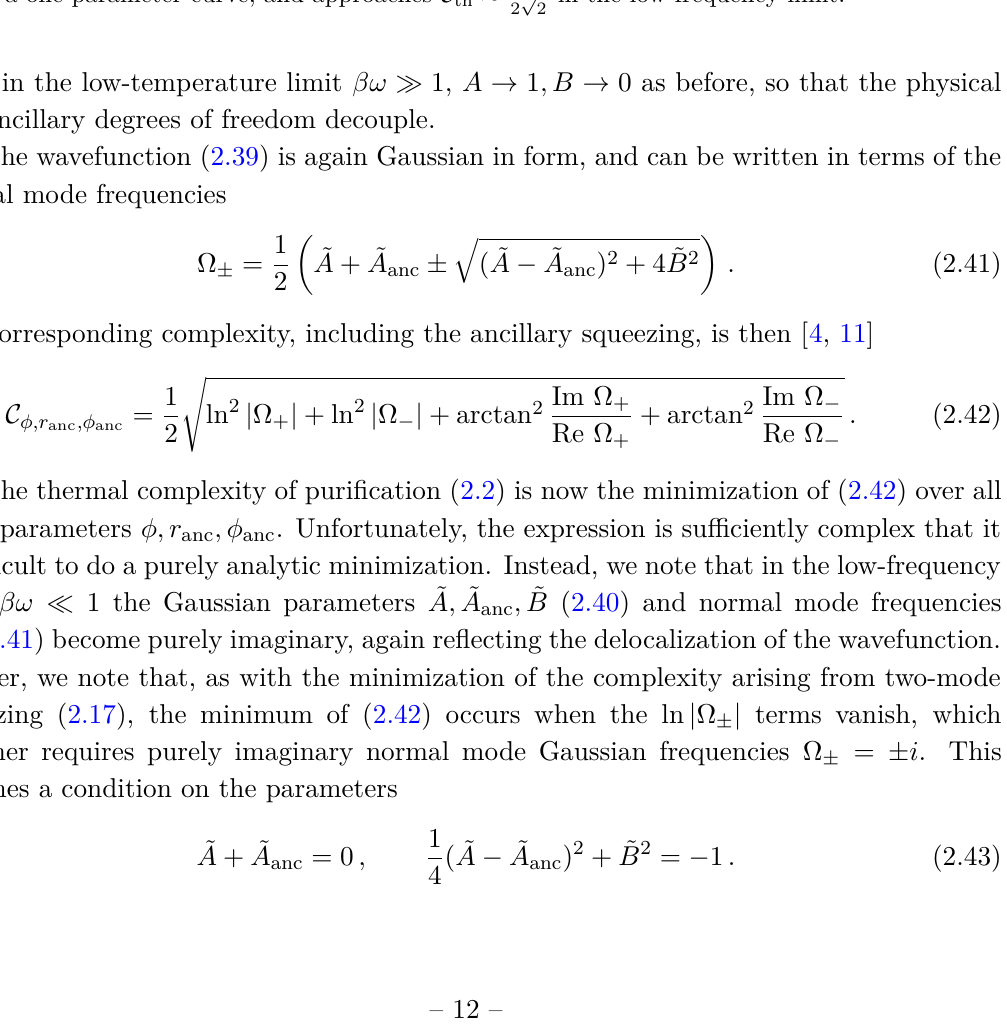
in the low-frequency √ 2 2